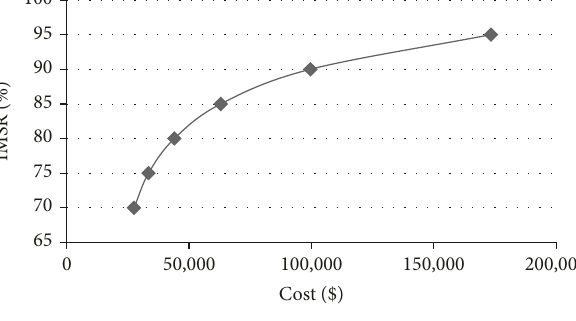
Table 4: Cost functions obtained after each iteration.